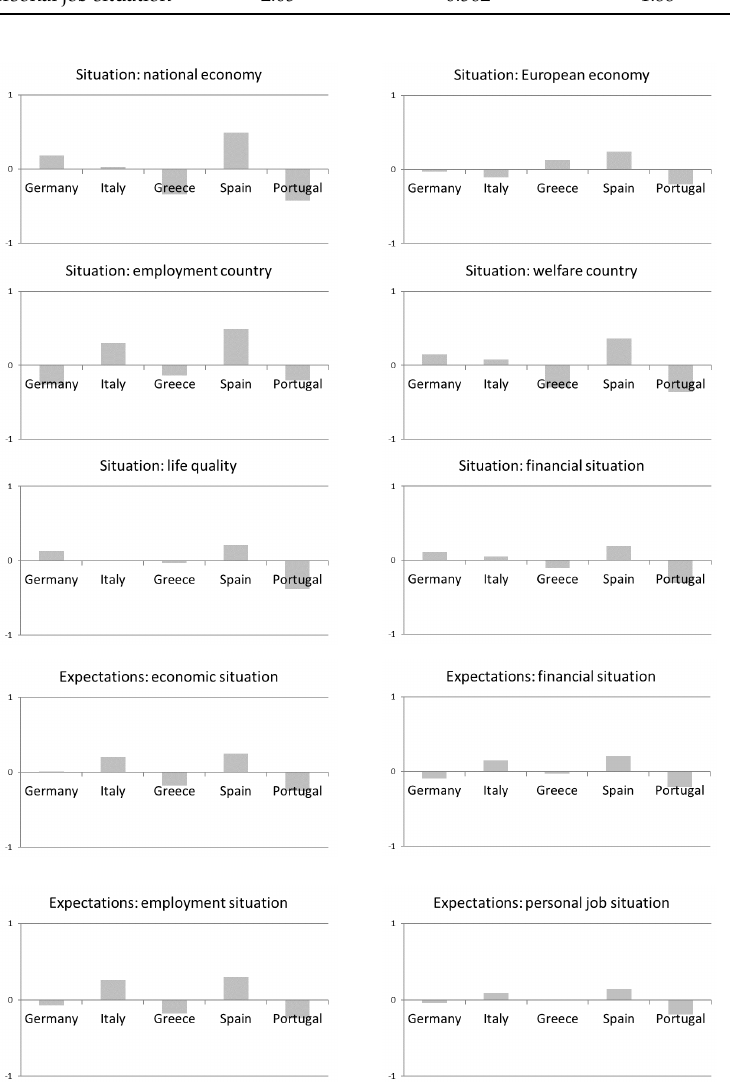
Figure 5. Differences among citizen evaluations and expectations regarding economic indicators in Germany, Spain, Italy, Greece, and Portugal in 2006 (mean evaluation in each country minus average evaluation for our five cases). Source is authors’ own elaboration from Eurobarometer 65.2.